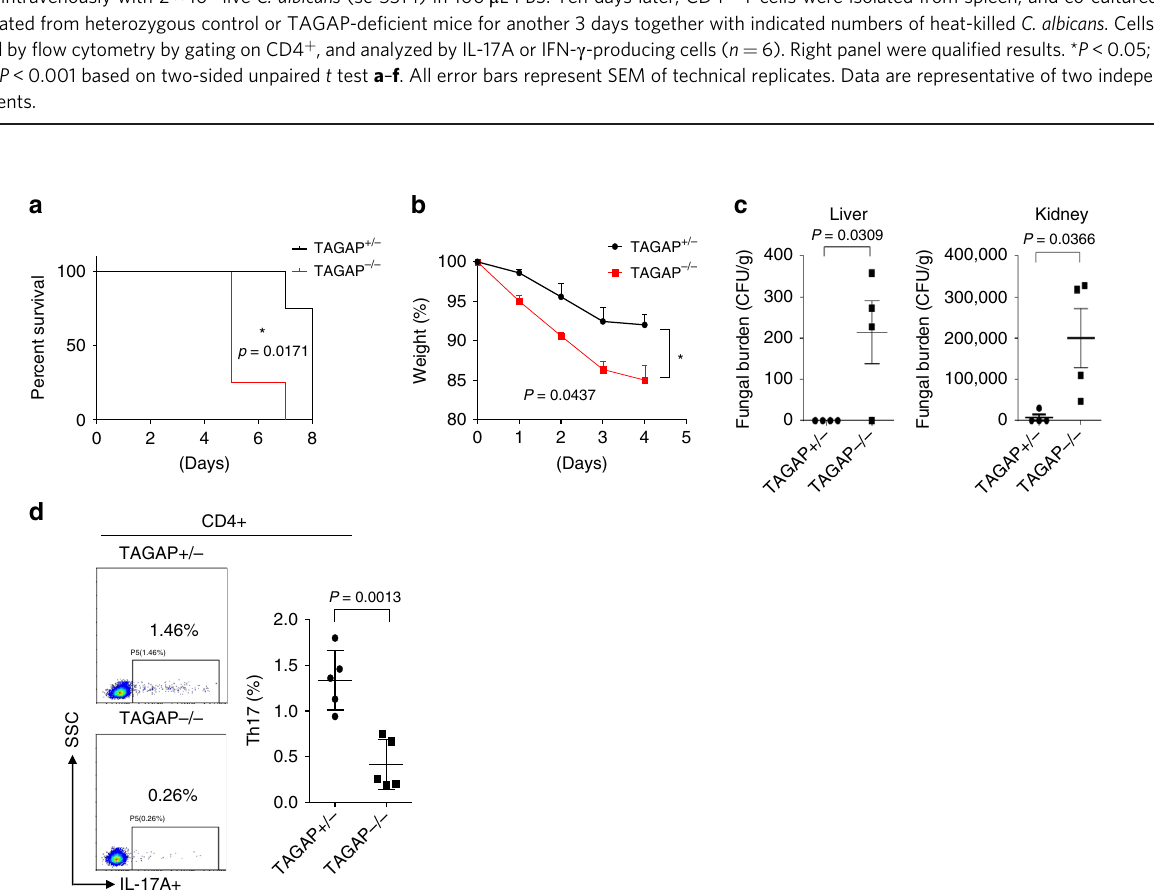
Fig. 6 TAGAP-de fi cient mice were susceptible to fungal infection. a , b Heterozygous control mice or TAGAP-de fi cient mice were infected with live C. albicans (5 × 10 5 ) through tail vein injection, and survival rate a or weigh loss b was shown ( n = 4). c Heterozygous control or TAGAP-de fi cient mice were infected with live C. albicans (2 × 10 5 ) through tail vein injection, and after 7 days fungal burden in liver and kidney were assessed as shown ( n = 4). d Heterozygous control or TAGAP-de fi cient mice were infected with live C. albicans (2 × 10 5 ) through tail vein injection, and after 7 days lymph node cells from heterozygous control or TAGAP-de fi cient mice were analyzed by fl ow cytometry by gating on CD4 + , and analyzed by IL-17A or IFN- γ -producing cells ( n = 5). All error bars represent SEM of technical replicates. * P < 0.05; ** P < 0.01; *** P < 0.001 based on two-way ANOVA a , b and two-sided unpaired t test c , d . Data are representative of two independent